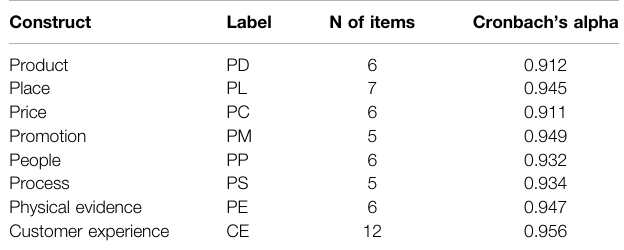
TABLE 4 | Internal consistency of the supplier